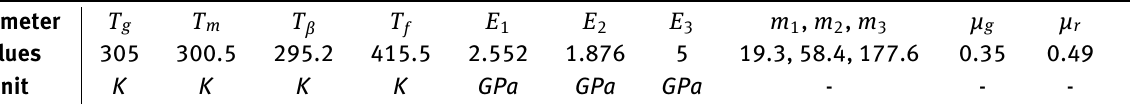
Table 1: Values of the parameters used to model the SMP matrix [35]